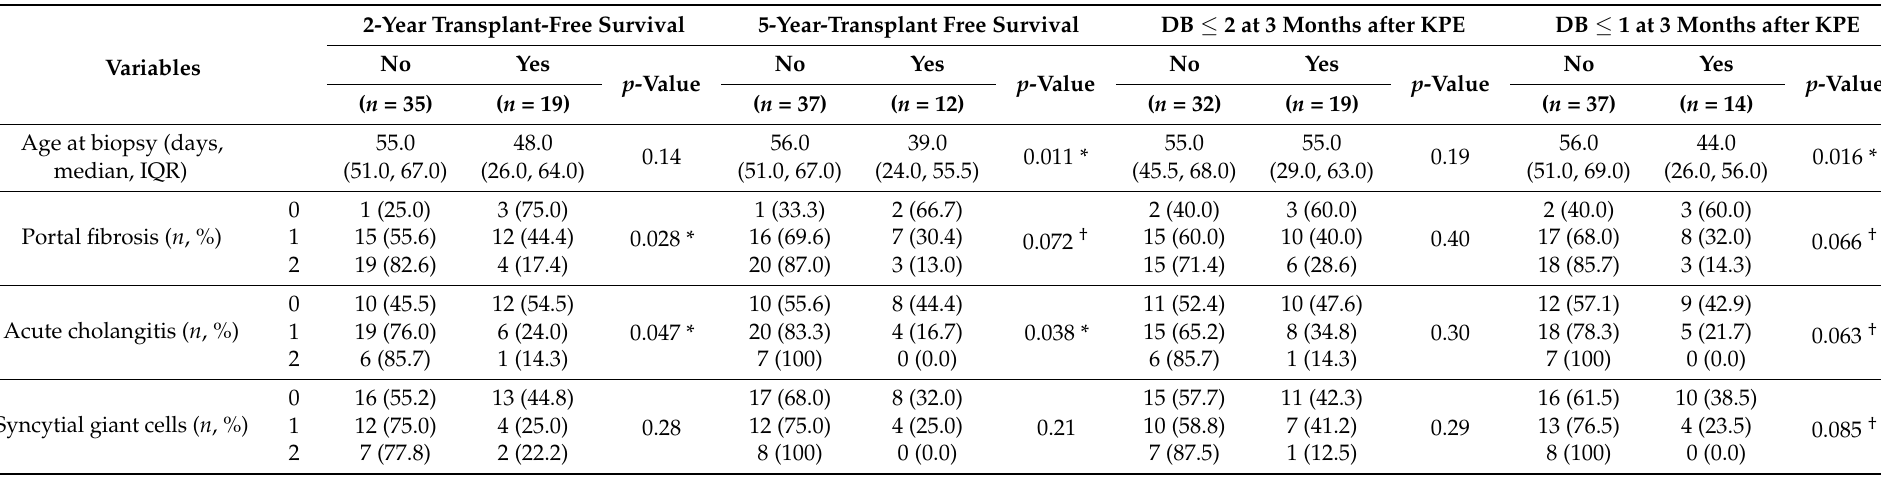
Table 4. Univariate analysis of clinical and histologic factors, tertiary scoring system. (Legend: DB: Direct bilirubin; KPE: Kasai portoenterostomy; (*): p value < 0.05 statistically significant; (†): p value < 0.1, statistical